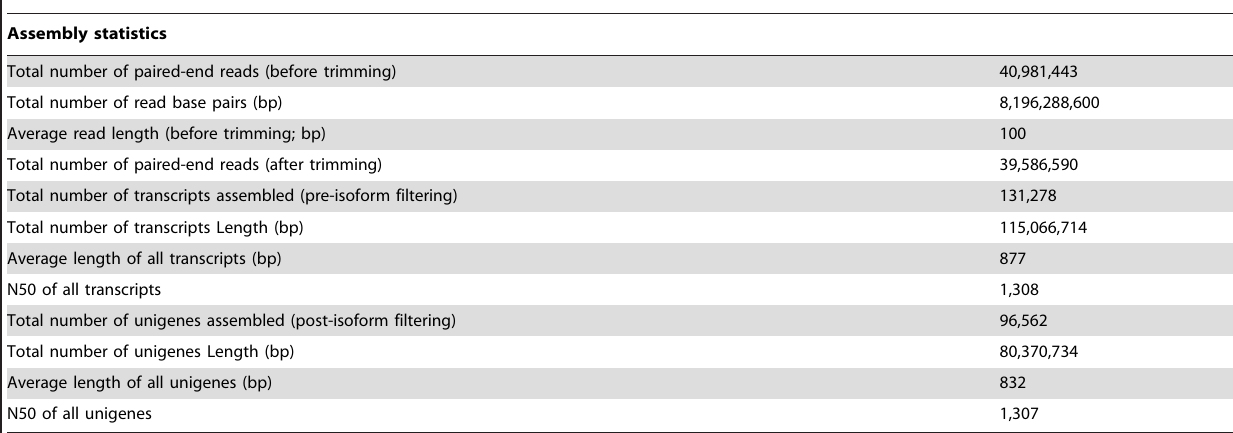
Table 1. Summary of Sinapis arvensis transcriptome assembly.